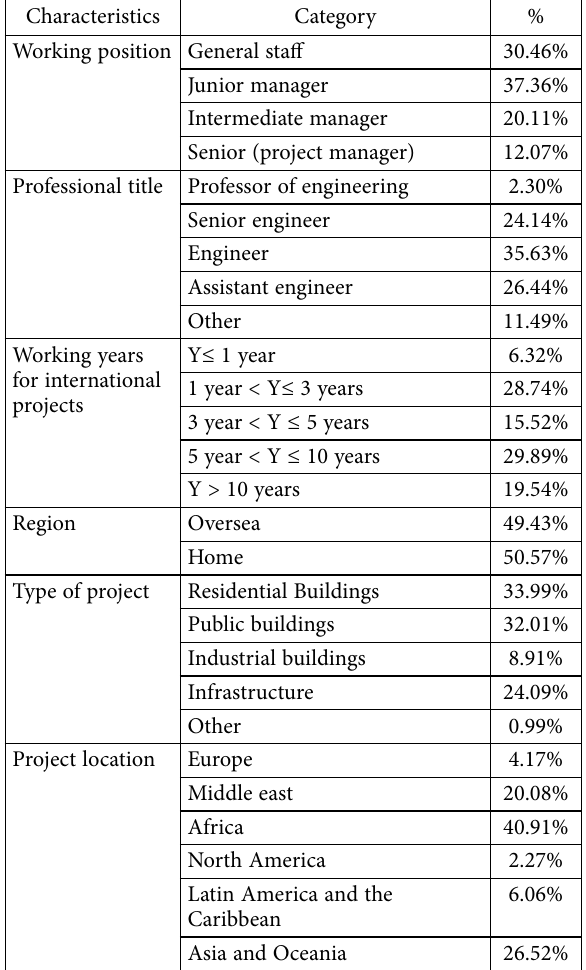
Table 3 Demographic distribution of the sample data